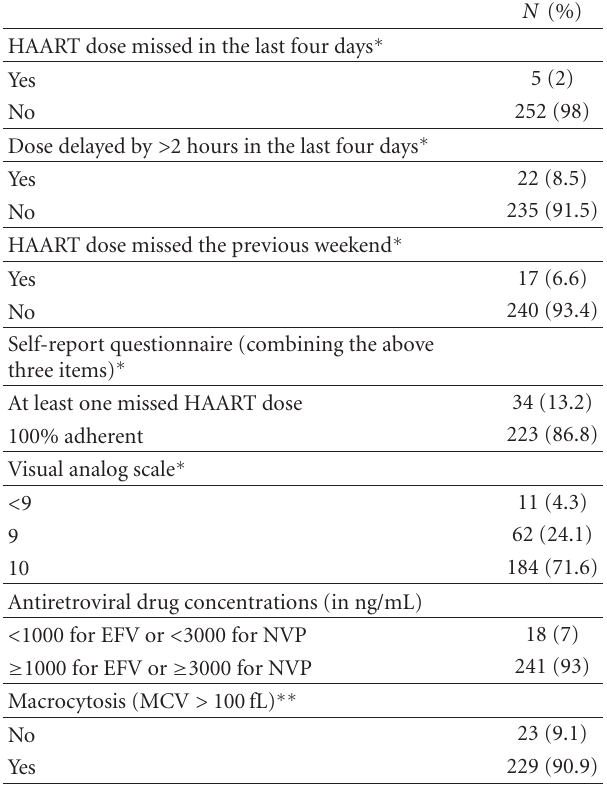
Table 1: Description of the tools used to assess